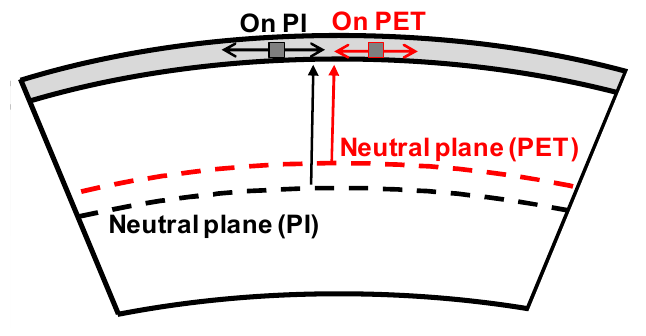
Figure 3. Schematic of the imposed strain on the sample on the different substrates. ( y 2 ) ∑ n − y 2 i = 0 B i i + 1 i ∑ (cid:3003) ((cid:3052) (cid:3284)(cid:3126)(cid:3117)(cid:3118) (cid:2879)(cid:3052) (cid:3284)(cid:3118) ) (cid:3289) 2 ∑ n i = 0 B i ( y i + 1 − y 1 ) (cid:3284) (cid:3284)(cid:3128)(cid:3116) According to the equation S = , where S is the location of the neutral plane, B is the biaxial modulus that is calculated by E/(1 − ν ), where E and ν are the elastic (cid:2870) ∑ (cid:3003) ((cid:3052) (cid:2879)(cid:3052) ) (cid:3289) (cid:3117) modulus and Poisson’s ratio, respectively, and y (i+1) − y 1 = ∆ y is the thickness of each (cid:3284) (cid:3284)(cid:3126)(cid:3117) (cid:3284)(cid:3128)(cid:3116) layer. The neutral plane position for the given multilayer systems can be calculated. To calculate the location of the neutral plane accurately, the biaxial modulus, which can be calculated with the value of the elastic modulus, must be measured. Nanoindentation tests with a Berkovich tip were performed on the PI and PET substrates, to measure the elastic modulus. Figure 4 shows the elastic modulus of the PI and PET substrates as a function of the tip displacement. The elastic modulus values of the PI and PET substrates were 5.27 ± 0.03 GPa and 3.31 ± 0.05 GPa, respectively. The hardness values of the PI and PET substrates were 0.15 ± 0.01 GPa and 0.23 ± 0.02 GPa, respectively (Figure 5).